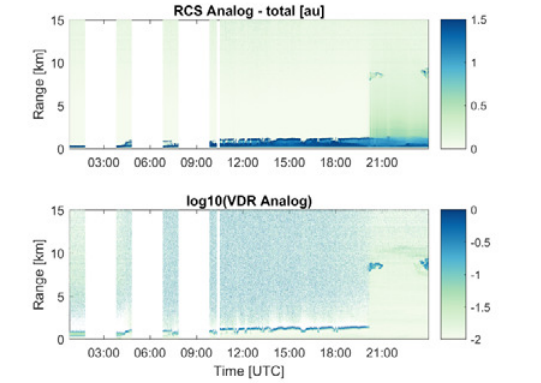
Figure 6. RCS (upper) and VDR (middle) at Watnall on 26/05/2016 during a biomass burning event